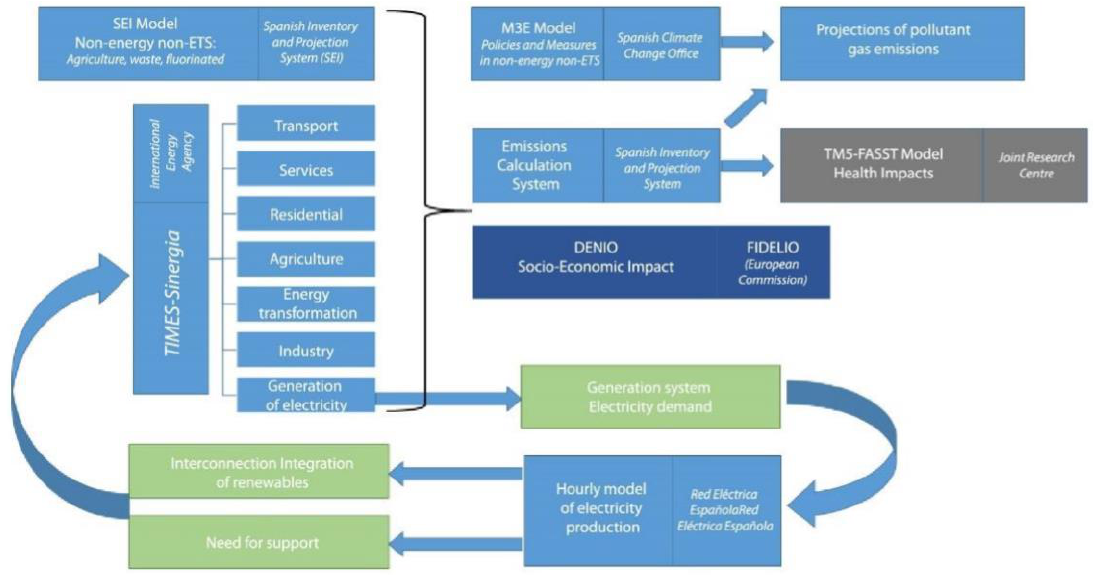
Figure 3. Sketch of the tools used to produce Spain’s Integrated National Energy and Climate Plan (INECP) 2021–2030 (from Figure B.1 in [15])